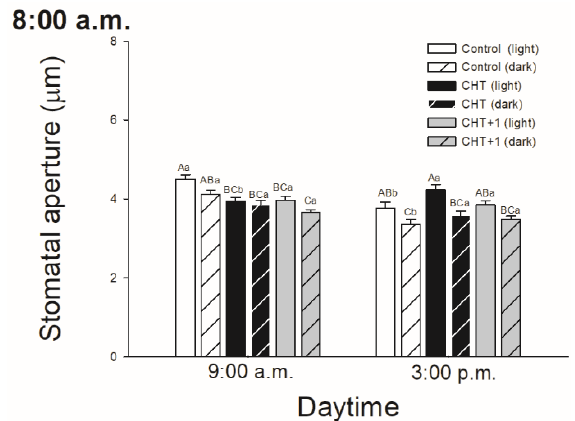
Figure 2. Changes in the size of stomatal apertures on the abaxial epidermal strips of intact tomato plants treated foliar with 100 μg mL -1 chitosan (CHT) dissolved in the experimental buffer (1 mM AA, 10 mM MES/TRIS, 10 mM KCl, 0.1 mM CaCl 2 , pH 6.15) in the morning at 08:00 hrs, keeping under light (normal columns) or in continuous darkness (stripped columns). Measurements were disposed at constant times after treatments (09:00 hrs and 15:00 hrs). Means ± SE, n = 3. Means were analyzed by two-way ANOVA, significant differences among the data were analyzed by Holm–Sidak test. Mean values significantly different at P < 0.05 were signed with different letters, upper case letters indicate the effects of the treatment at the same daytime, and lower case letters indicate the effects of the daytime under the same treatment. (Control: treatment with 1 mM Acetic acid buffer (AA); CHT: treatment with 100 μg mL -1 chitosan in experimental buffer containing AA; CHT+1: untreated distal leaf level from the CHT-treated one).